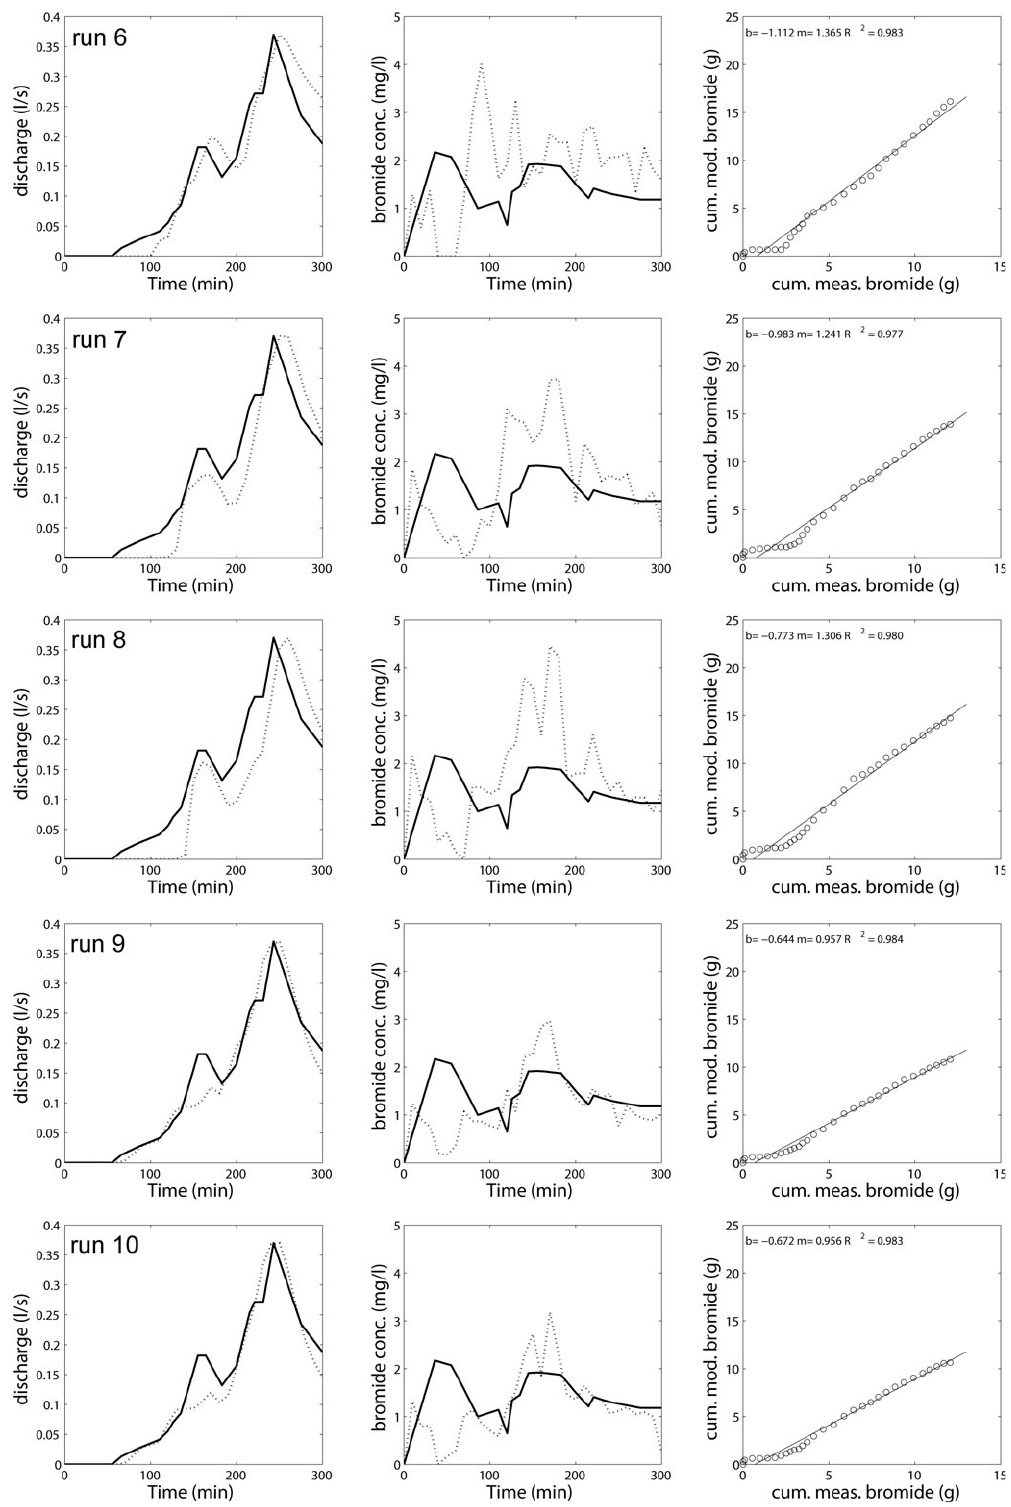
Fig. 4. The left column presents the observed discharge (solid line) and the modelled discharge (dotted line), the centre column presents the observed (solid line) and modelled (dotted line) bromide concentrations in the tile drain, while the right column presents the cumulated modelled bromide outflow versus the measured one and a linear regression line between them (b denotes the intersect and m the slope of the regression). The runs 6 to 10 are shown